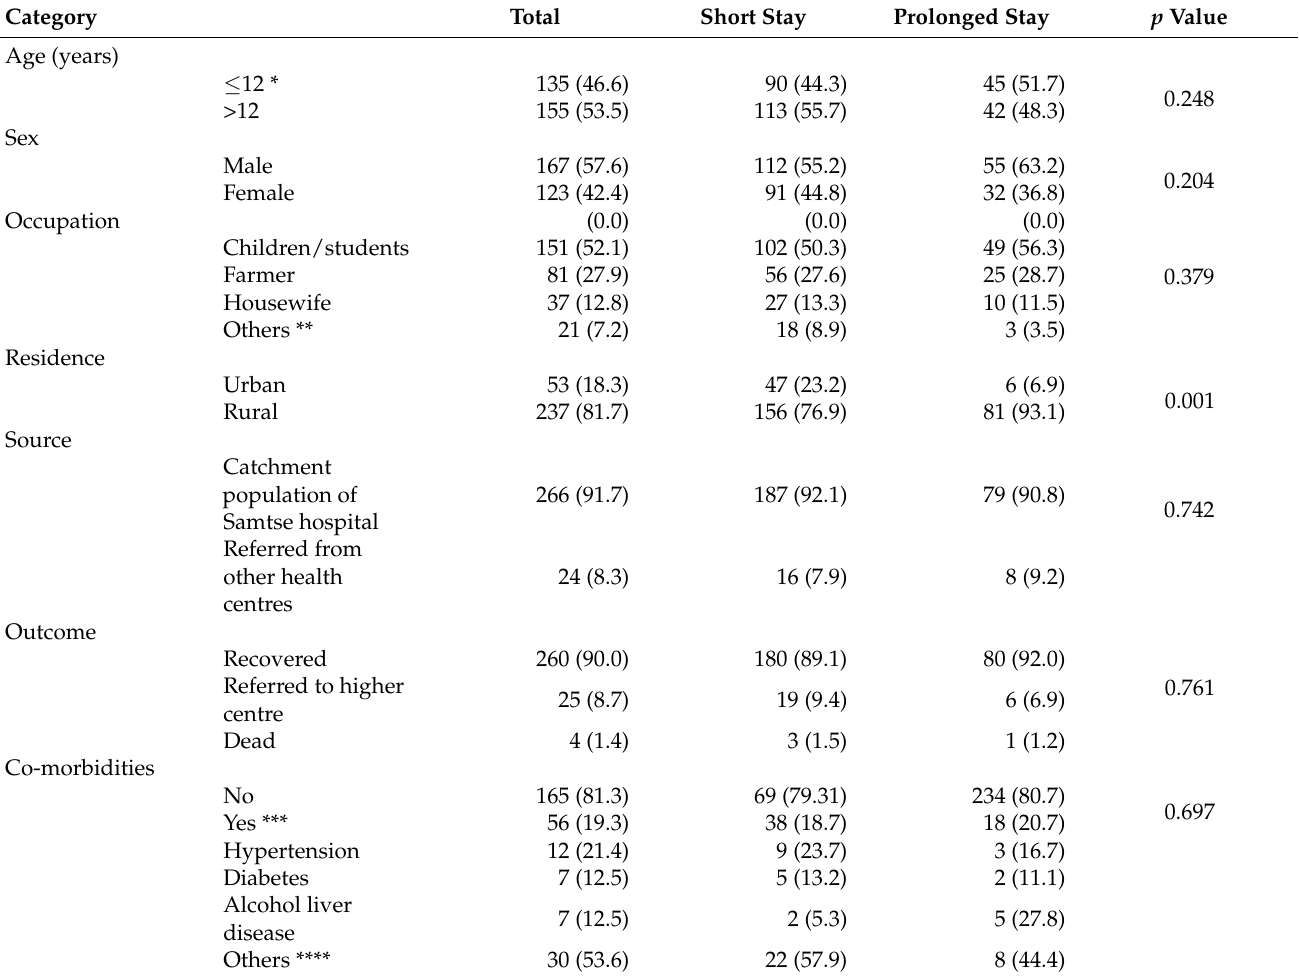
Table 1. Characteristics of fever admissions by the length of stay in Samtse Hospital, Bhutan,